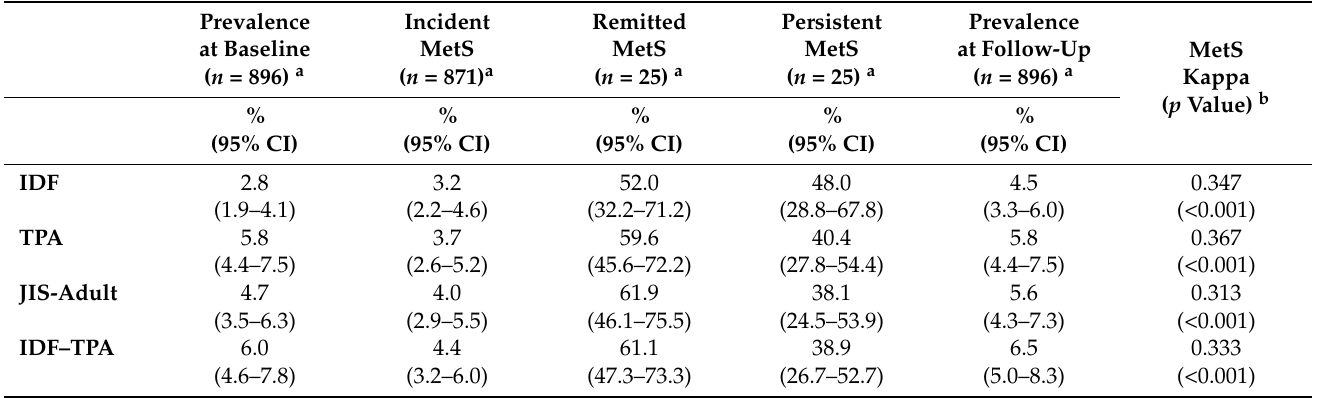
Table 3. Baseline and follow-up prevalences and proportions of metabolic syndrome transformation in adolescents over the 2 years of